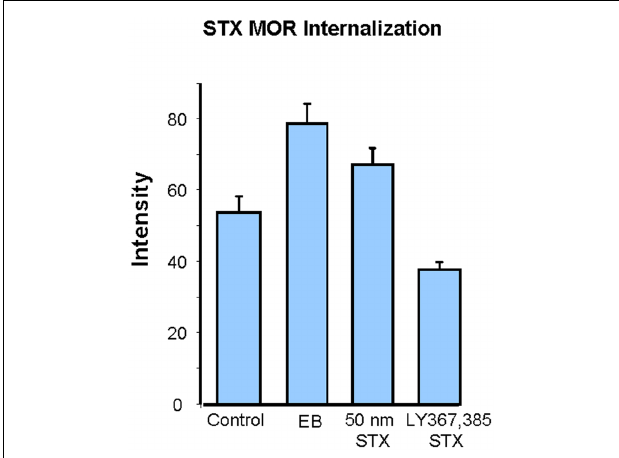
FIGURE 2 | Comparison of estradiol with STX-induced μ -opioid receptor (MOR) in the medial preoptic nucleus (MPN). Estradiol, STX, LY 367,385, and control (aCSF) were injected into the arcuate nucleus of the hypothalamus of OVX rats and then transcardially perfused 30min later with chilled 0.9% saline followed by 4% paraformaldehyde in Sorenson’s buffer. Sections from the arcuate nucleus (ARH) were processed for MOR internalization using rabbit primary antibodies directed against MOR (1:24,000; Neuromics). Histogram illustrates the ability of STX to induce MOR internalization similar to EB, as measured by immunofluorescence staining intensity in the MPN. Blocking mGluR1a with the antagonist LY 367,385 attenuates STX-induced MOR internalization. * Represents p < 0.05 compared to control as determined by one-way